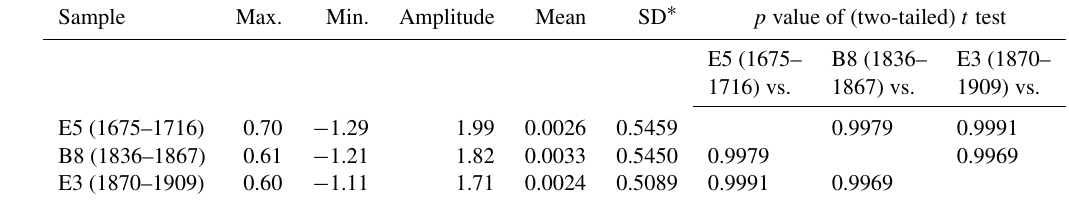
Table 3. Statistical overview for mean annual cycle data of the coral Sr / Ca–SST [ ◦ C] records. Sample Max.